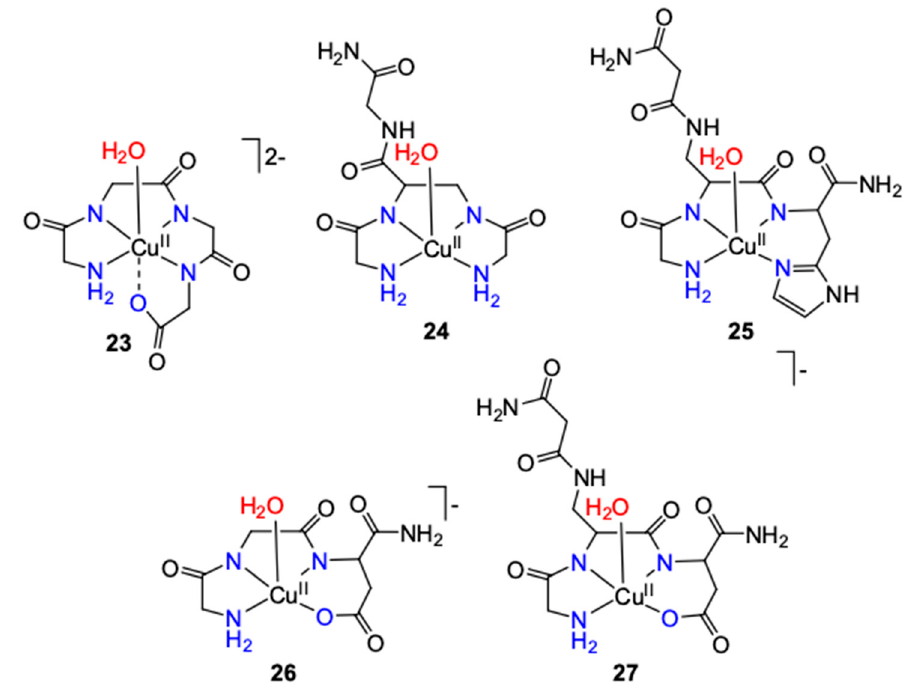
Figure 13. Peptide-based Cu catalysts for water oxidation.